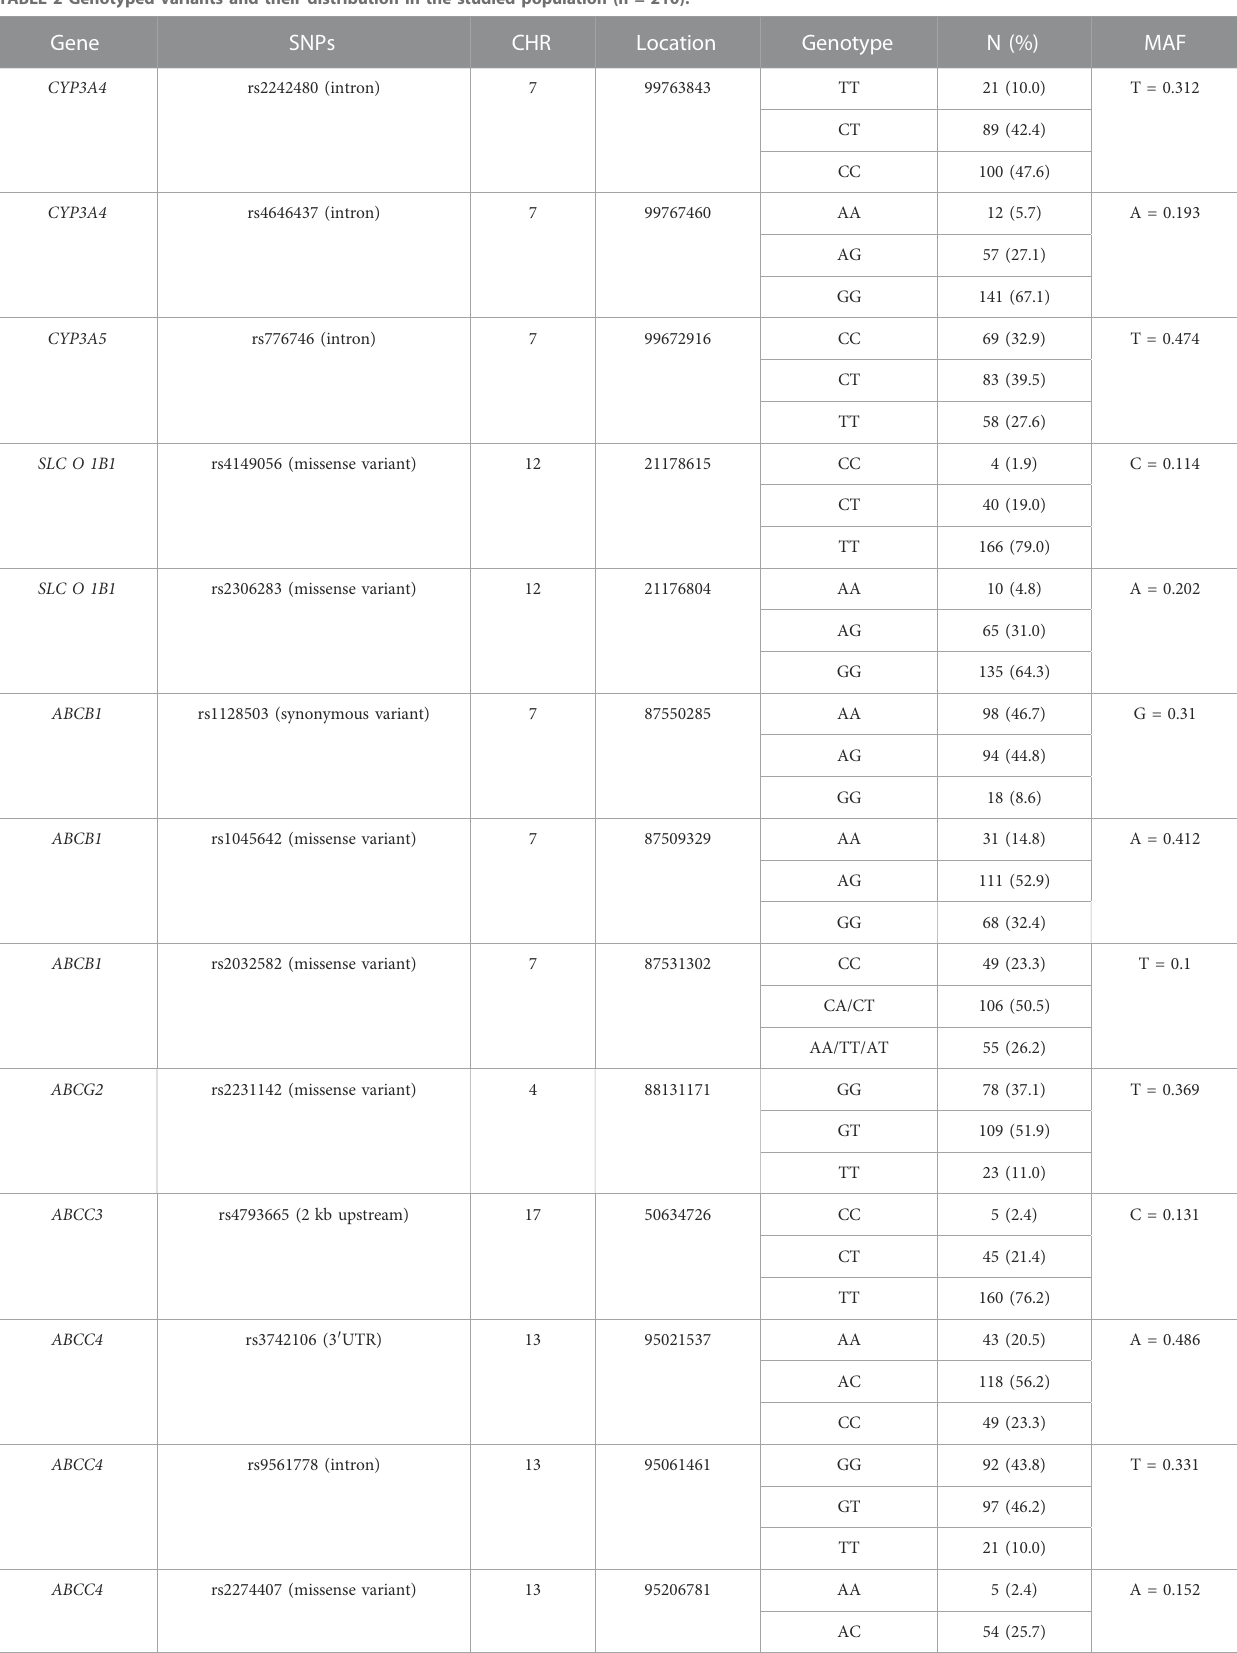
TABLE 2 Genotyped variants and their distribution in the studied population (n = 210).